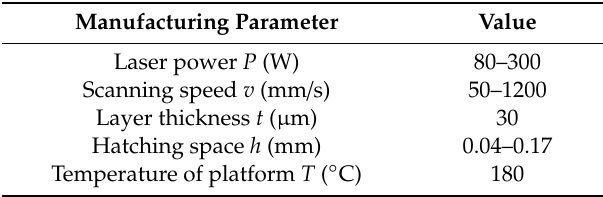
Table 2. The manufacturing parameters of SLM used in this